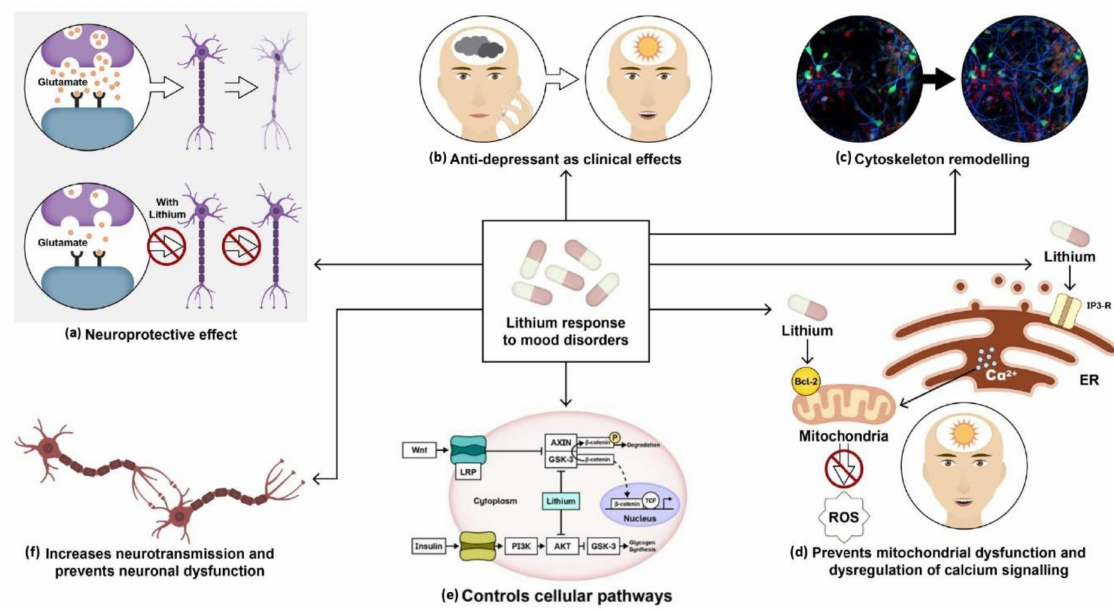
Figure 1. Molecular and therapeutical potential of lithium: ( a ) Lithium prevents neuronal dysfunction by inhibiting the activation of apoptotic pathways. Chronic lithium treatment protects neurons against excitotoxicity. ( b ) Lithium salts have been widely used as anti-manic and anti-depressants. ( c ) It plays a vital role in cytoskeleton remodeling and neurite outgrowth. ( d ) It upregulates neuroprotective protein BCl-2, which prevents mitochondrial dysfunction and calcium channel dysregulation. ( e ) It activates wnt and insulin pathways by inhibiting constitutively activated glycogen synthase kinase-3 (GSk-3) in both pathways. ( f ) It also regulates neurotransmission and prevents synaptic